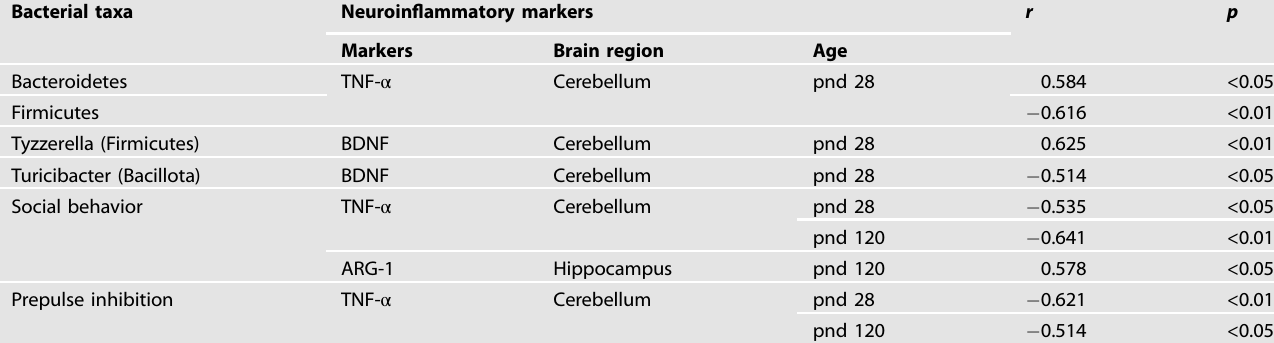
Table 1. Correlations of neuroin fl ammatory markers with bacterial taxa and behaviors. Bacterial